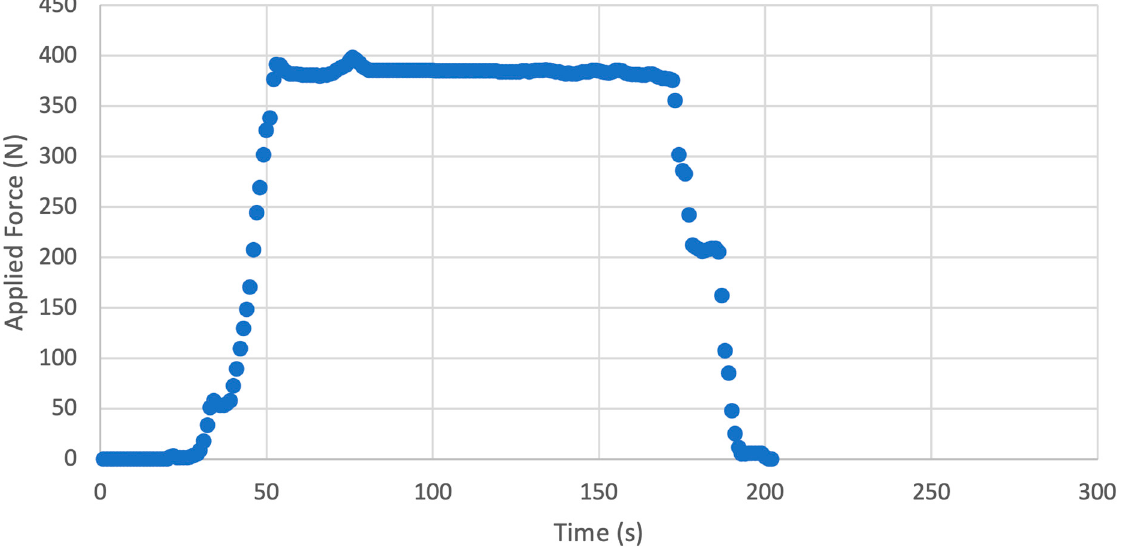
Figure 7. Direct screw press applied force as a function of time.